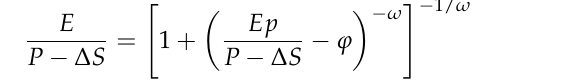
Figure 4. Result of Mann–Kendall mutation analysis in the Tangnaihai station from 1967 − 2016.